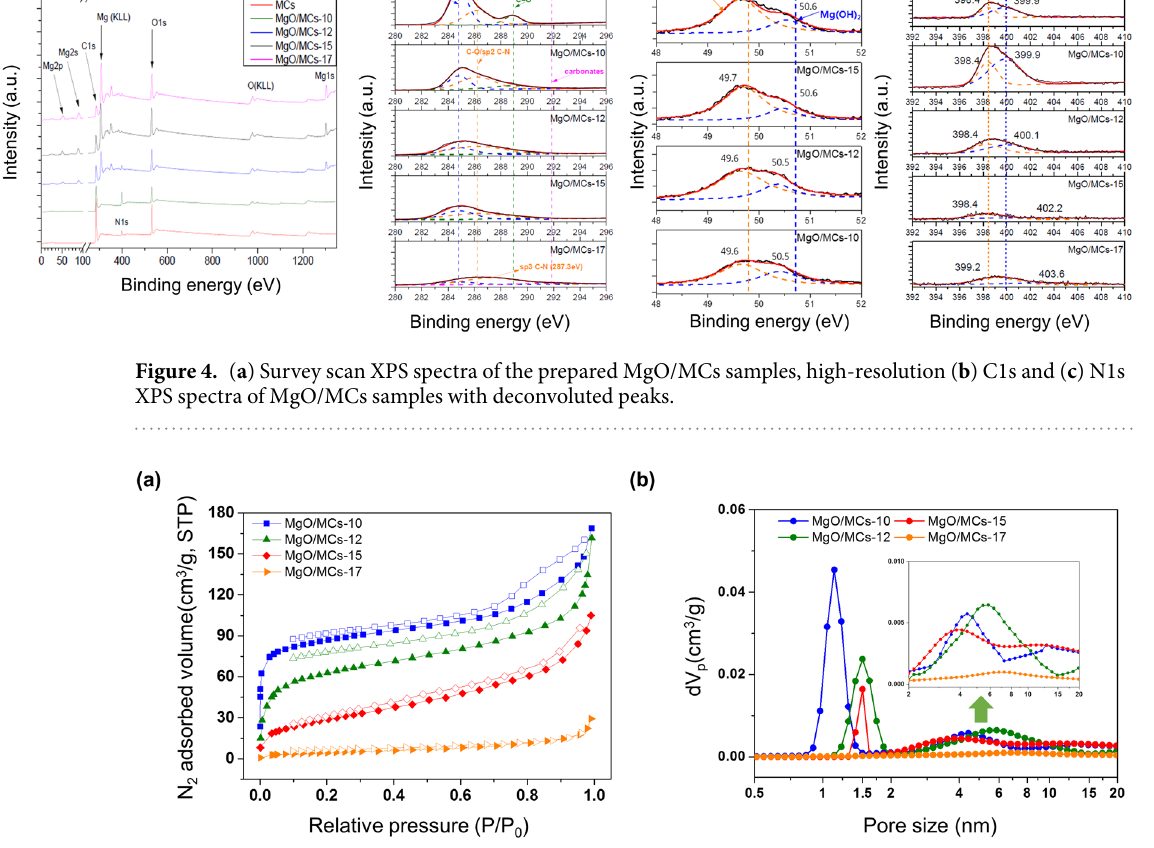
Figure 5. ( a ) 77 K/N 2 adsorption (closed symbols) and desorption (open symbols) isotherms and ( b ) NLDFT pore size distributions of the prepared samples. Inset indicates mesopore size